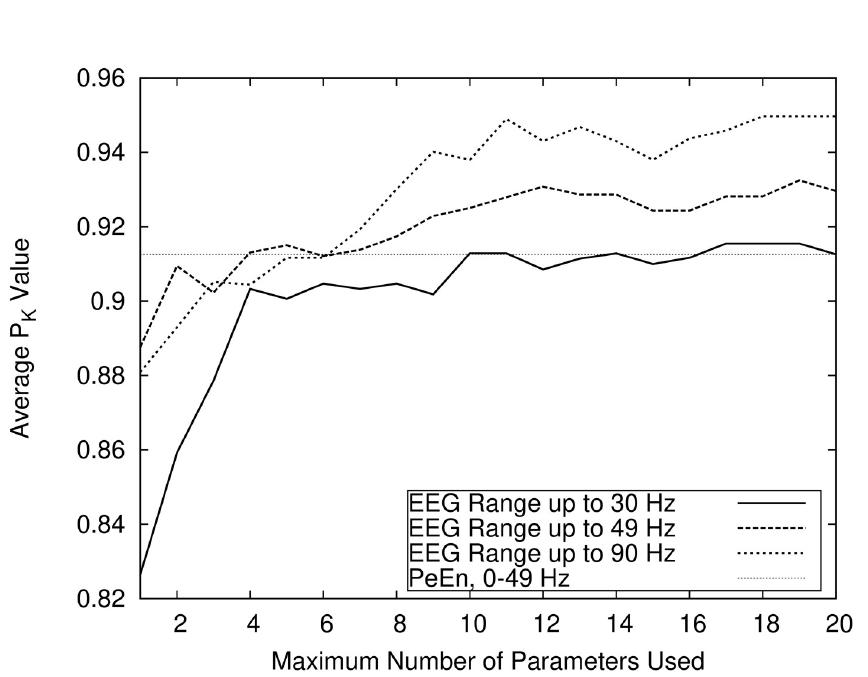
Fig 4. Influence of the EEG low pass filter setting on prediction probability. Comparison of the influence of the EEG low pass filter settings (fhigh) on prediction performance. The figure shows that an increase in the EEG signal range leads to an increase in prediction accuracy. The single EEG parameter PeEn (permutation entropy) is shown for comparison.